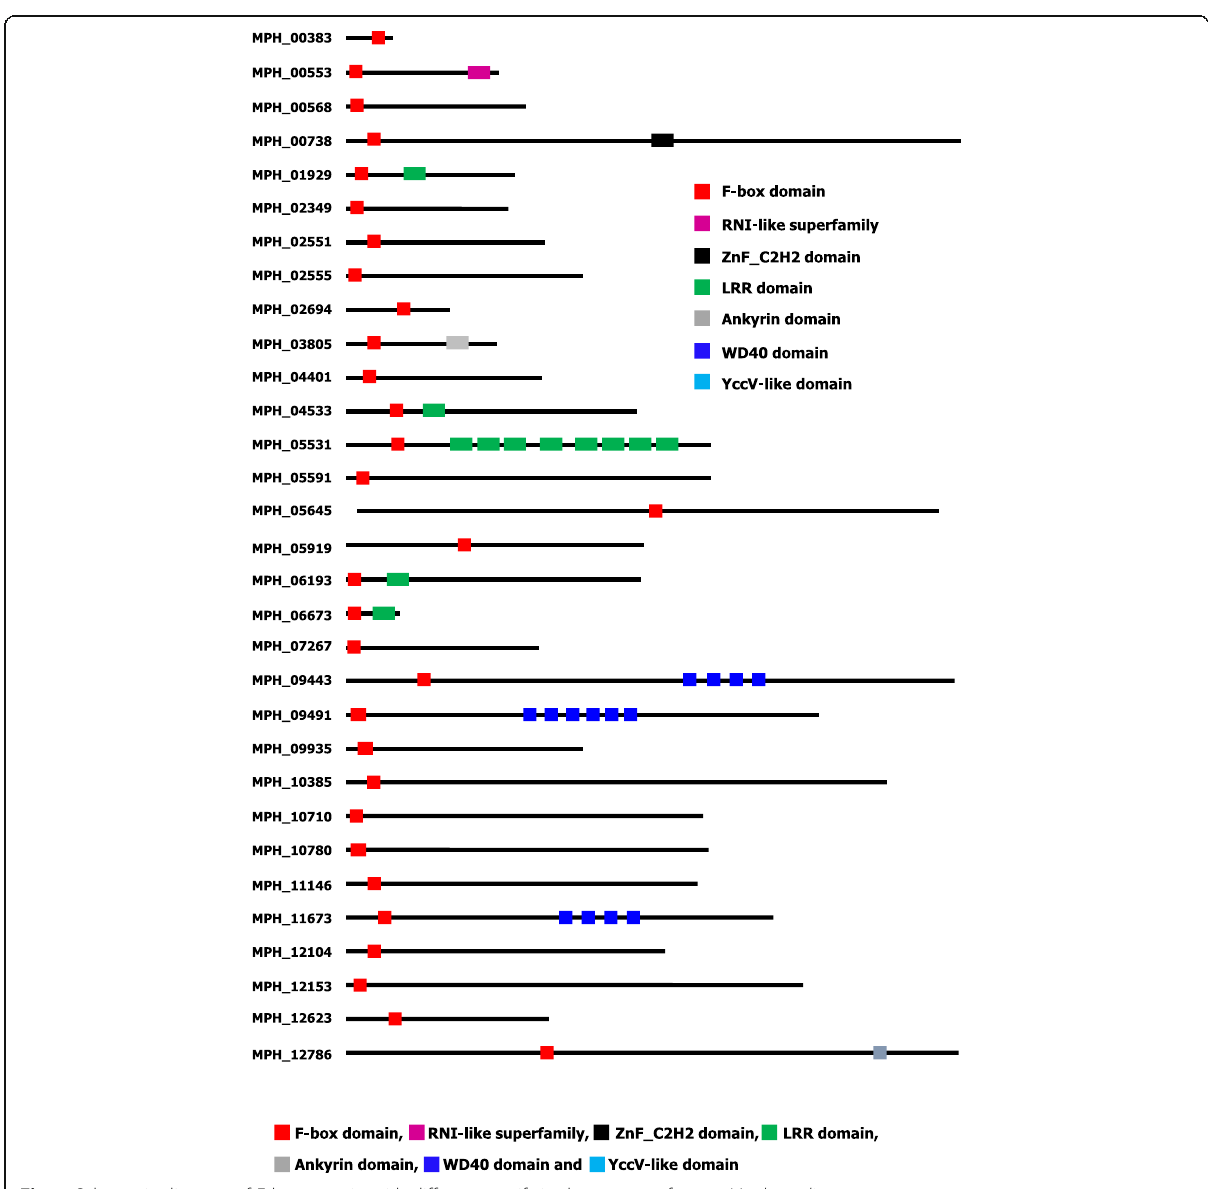
Fig. 1 Schematic diagram of F-box protein with different motifs in the stem rot fungus M.